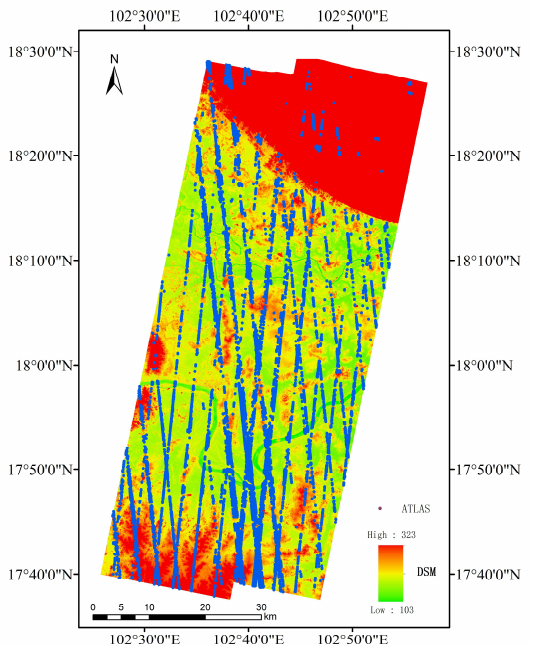
Figure 10. Distribution of generated DSM and extracted ATLAS LPs.